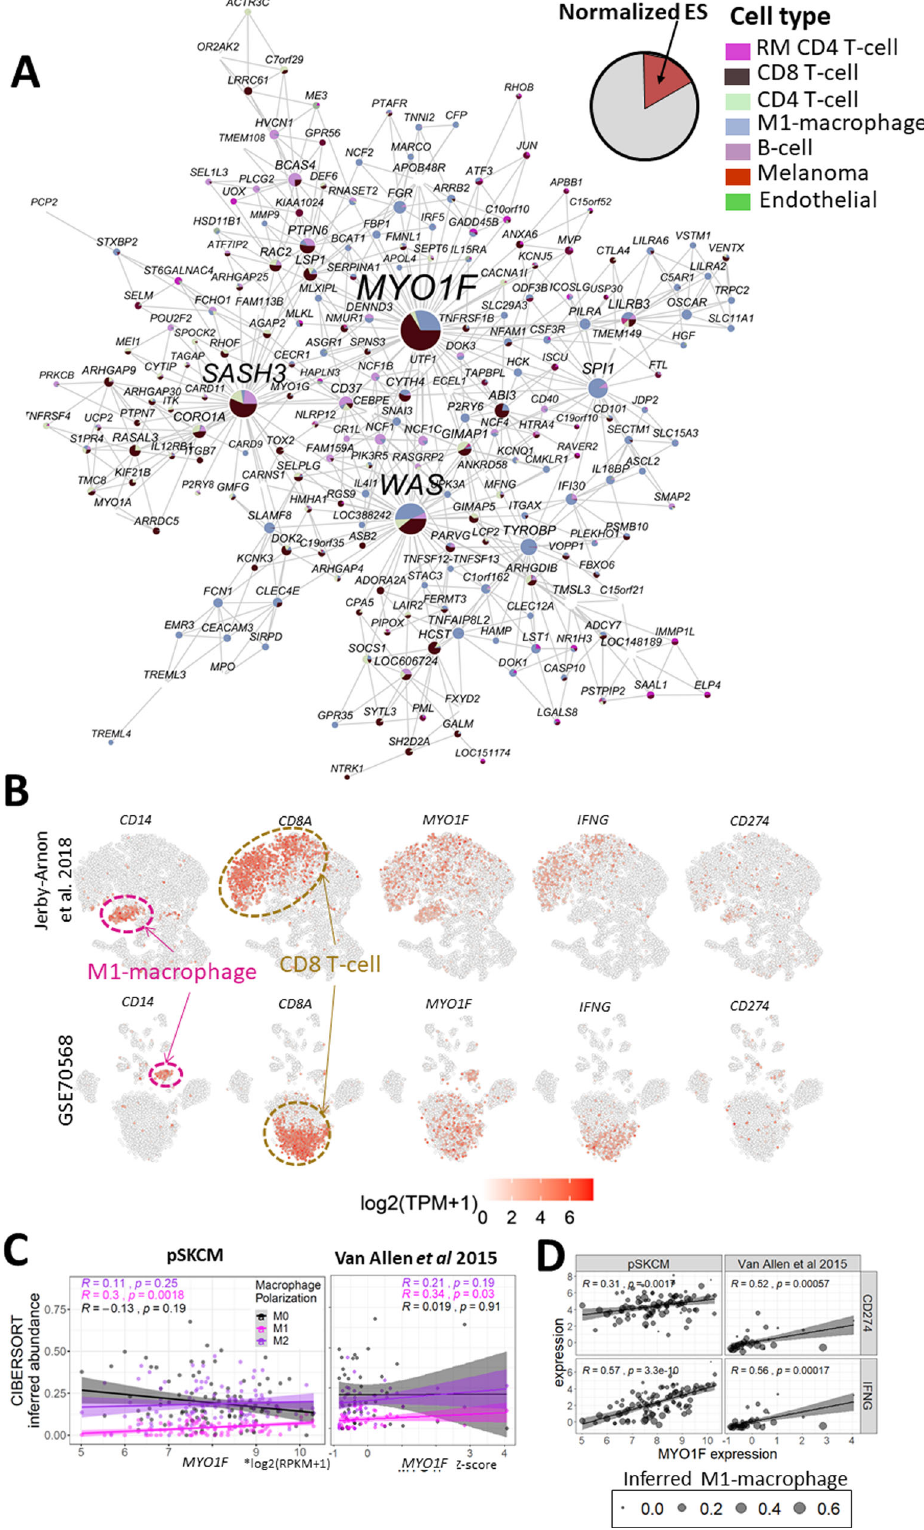
SKmel147 and A375 cells (Table